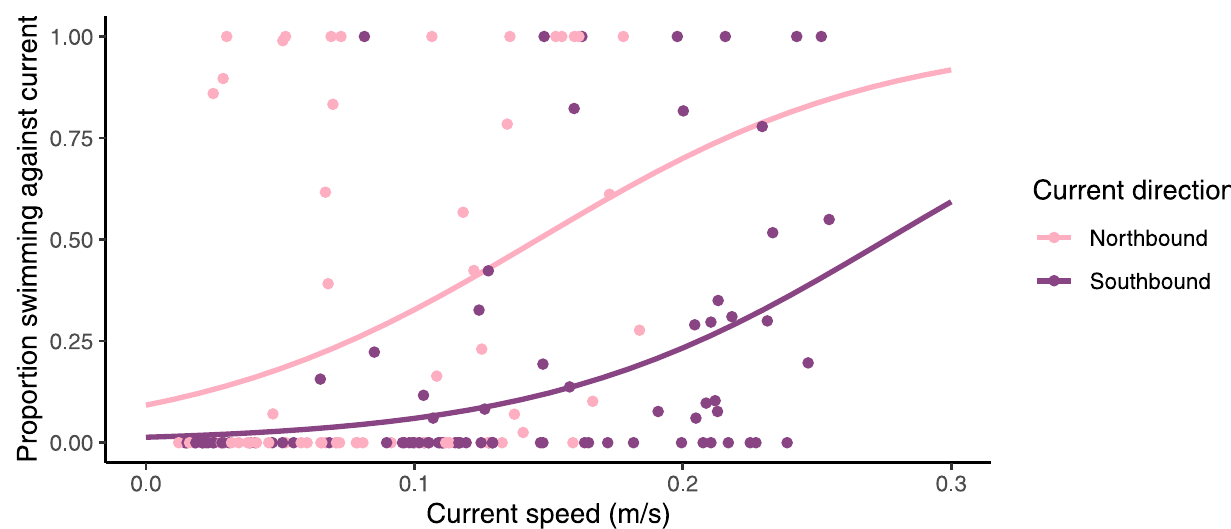
Fig 6. Proportion of time spent by the majority of the salmon in frame standing on current. Points are proportion of time where the salmon were standing on current in a video. Lines represent model predictions of the probability of a video having salmon standing on current a majority of the time. Model predictors are current speed and direction. Lighter colour signifies a northbound current direction whereas a darker colour signifies a southbound current direction.